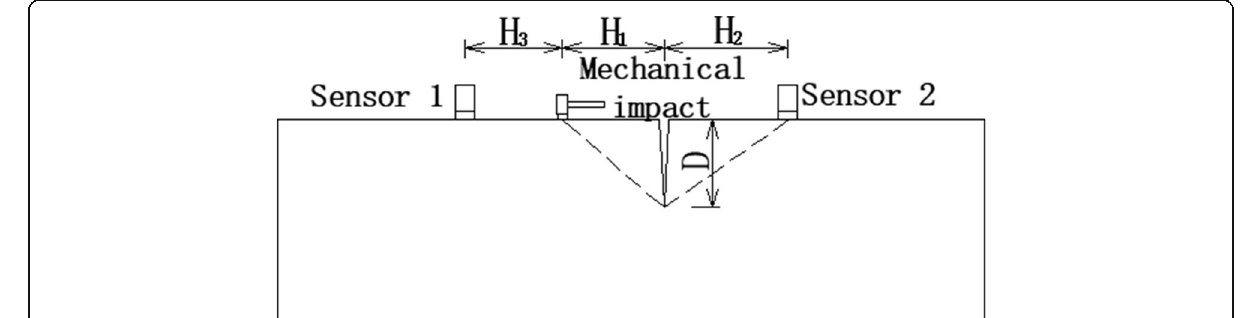
Fig. 1 Schematic of testing configuration for estimating the depth of the